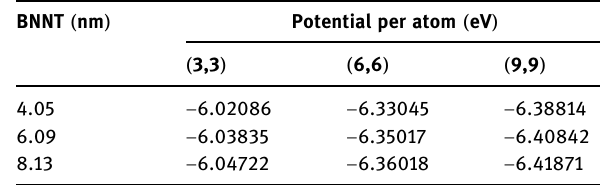
Table 1: The average potential per atom for the three kinds of BNNTs with di ff erent lengths